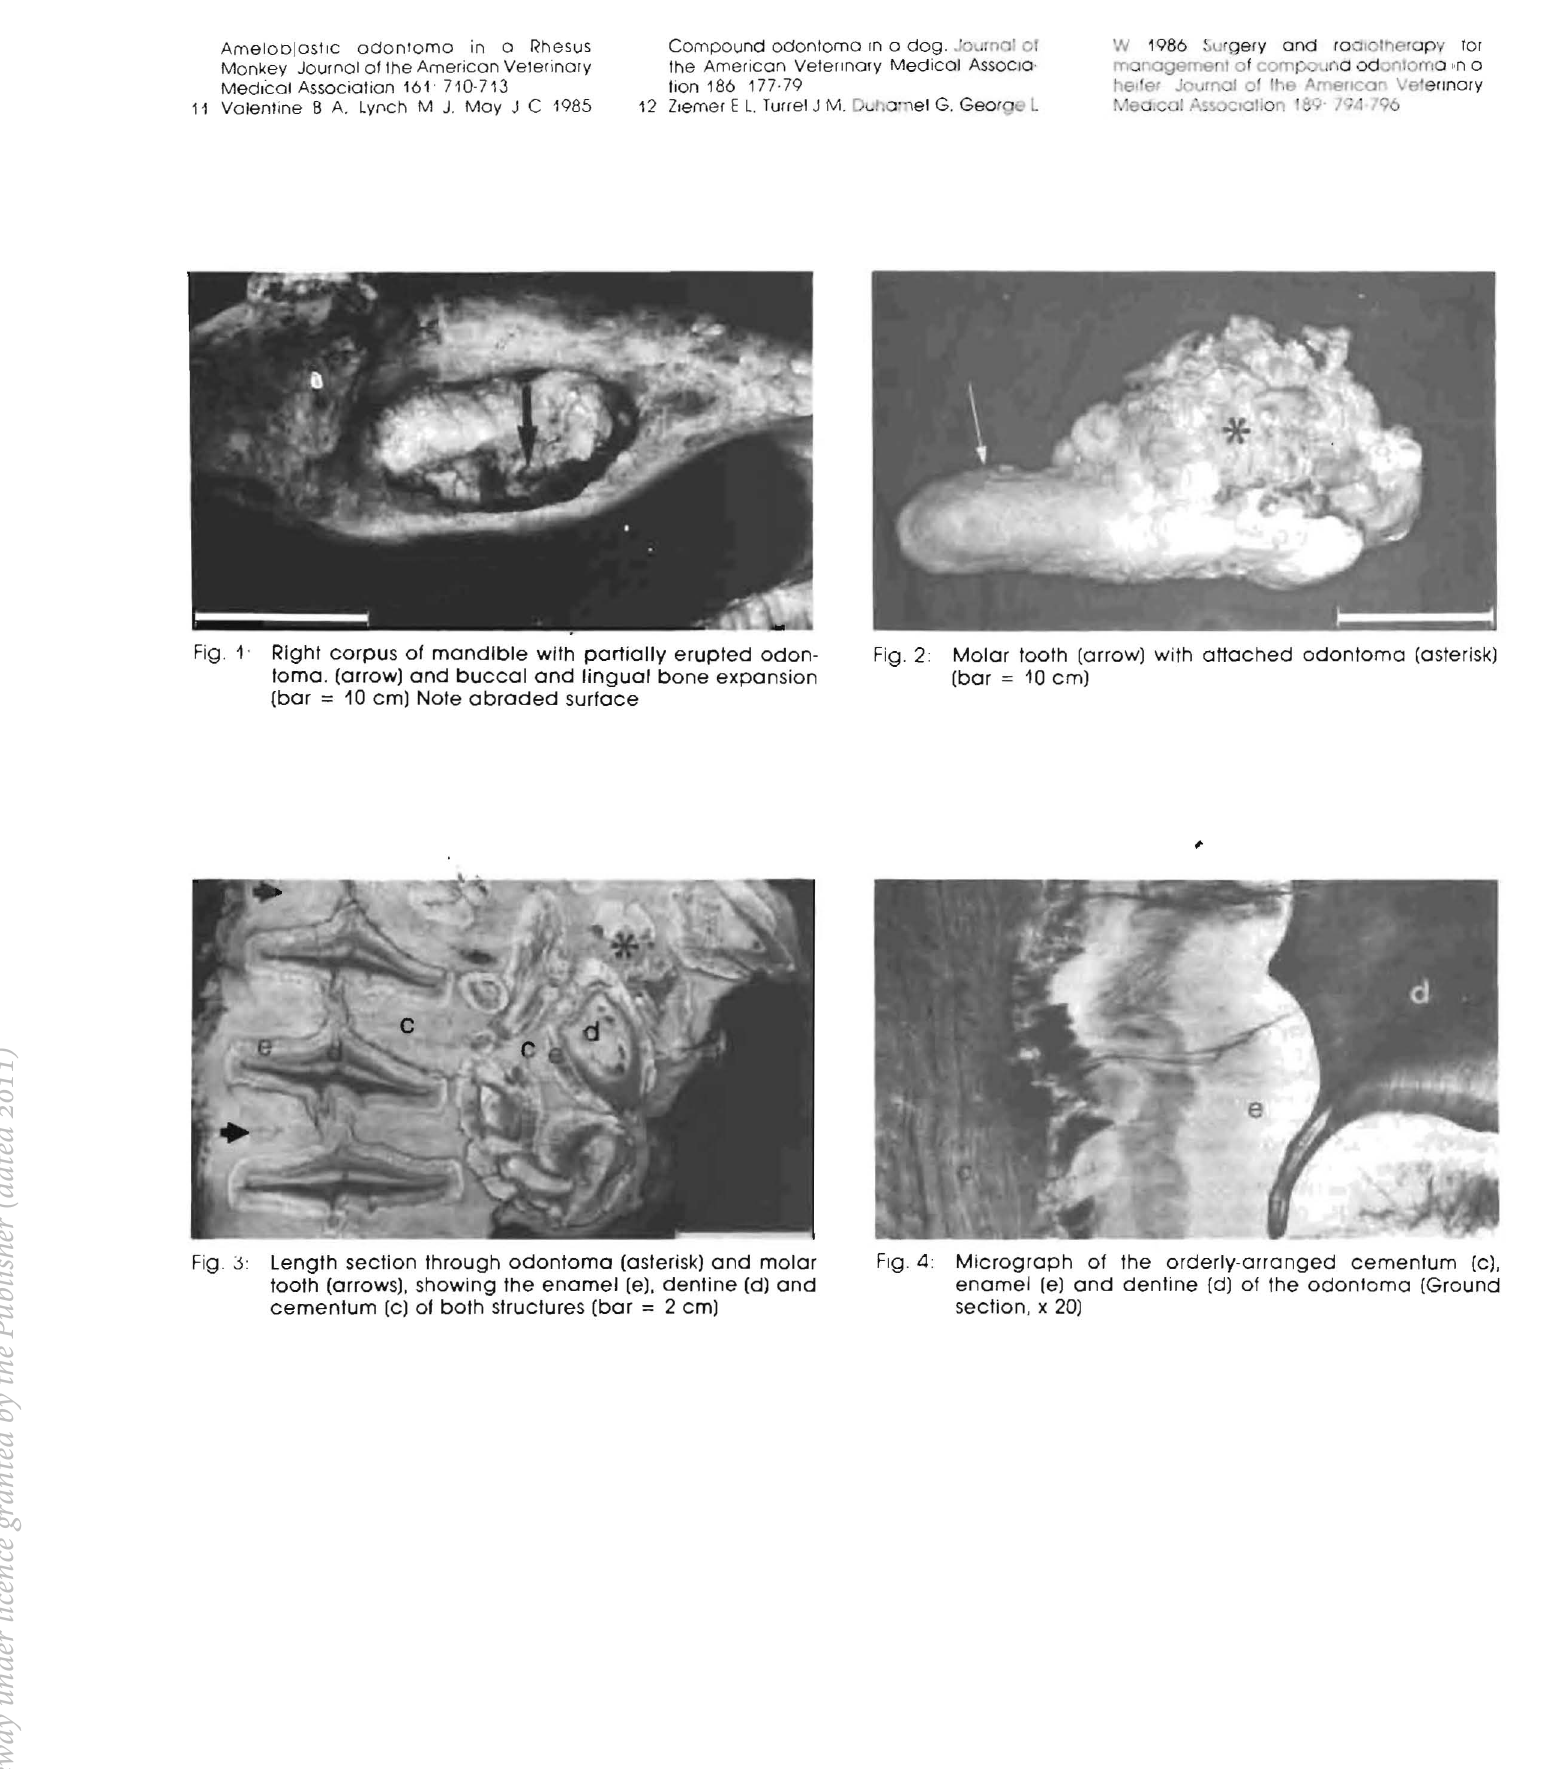
Fig . j: Length section through odontoma (asterisk) and molar tooth (arrows), showing the enamel (e), dentine (d) and cementum (c) of both structures (bar = 2 cm)